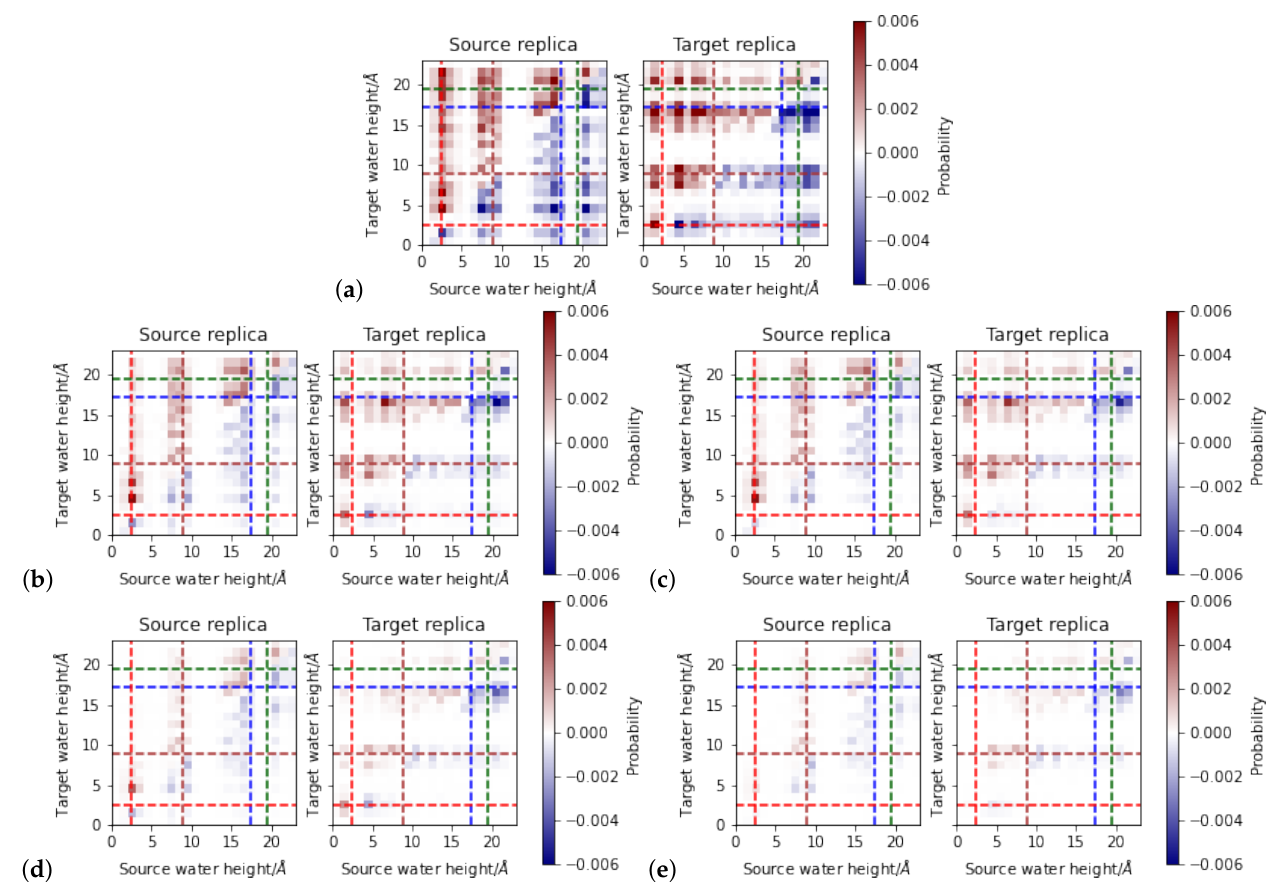
Figure 9. Position-dependent acceptance ratio for proton exchange in “down” models. Blue and minus signs indicate “downwards” (direction from Y288 to H96) transitions and red indicates “upwards” (direction from H96 to Y288) transitions. Dashed lines indicate the average position of protein residues E101 (red), S365 (brown), K362 (blue), and T359 (green). ( a ) Energy as only acceptance criterion, ( b ) existence of a hydrogen-bonded connection in the source replica ( c ) existence of a directed hydrogen-bonded connection in the source replica, ( d ) existence of a directed hydrogen-bonded connection in the source replica, and ( e ) existence of a directed hydrogen-bonded connection in the source and target replica as additional